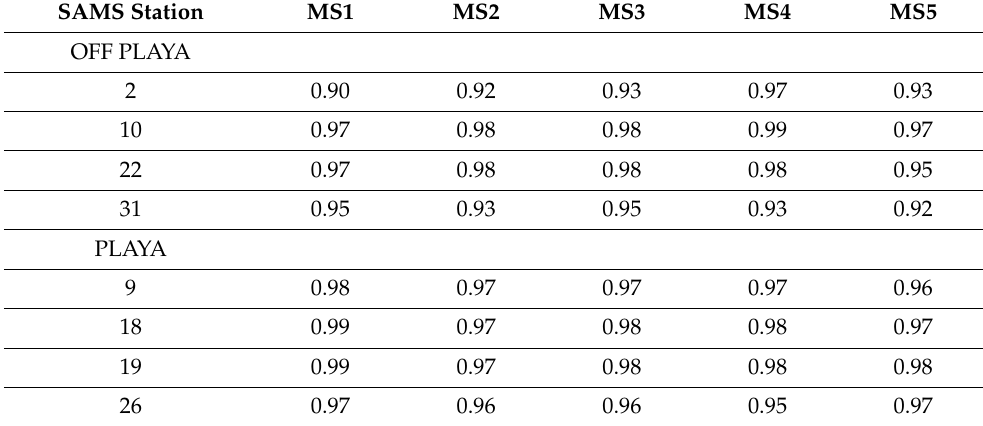
Table 8. Aggregate 2 m AGL temperature correlation coefficient R values for each model setup.